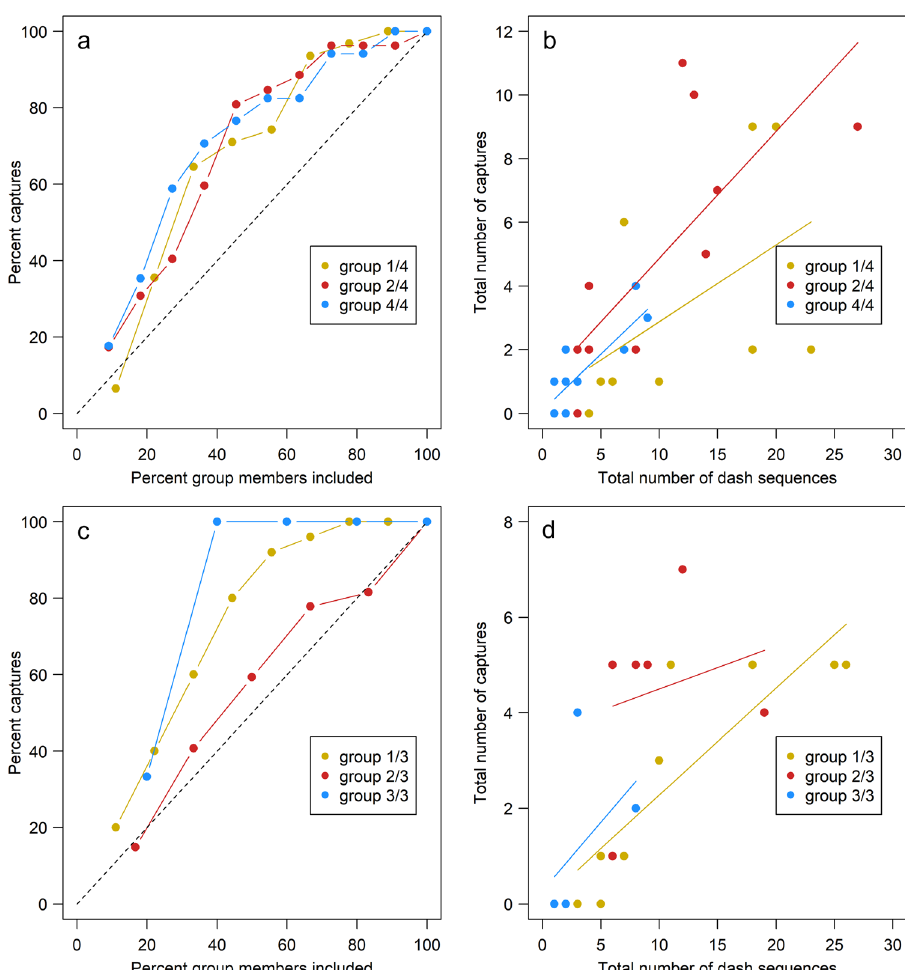
Fig. 3 Division of prey within sub-groups. a , b 2018 data; c , d 2019 data. a , c For the scenario of four subgroups in 2018 and three subgroups in 2019 (due to very small group sizes in 2019 for the scenario of four subgroups), the relationship between the percentage of prey captured and the percentage of group members — sorted in descending order of their number of dash sequences — showing the unequal division of prey between group members. For the different subgroups — 2018: 1/4 ( ), 2/4 ( ) and 4/4 ( ); 2019: 1/3 ( ), 2/3 ( ) and 3/3 ( ), — approx. 70 – 80% of sardines are captured by less than 50% of the members. Group 3 is not shown in a , b – 2018 - because it only contained three members. Deviations from the diagonal dotted line show that the division of prey is unequal. b , d Within each of the subgroups, individuals with a higher number of dash sequences also had a higher total number of